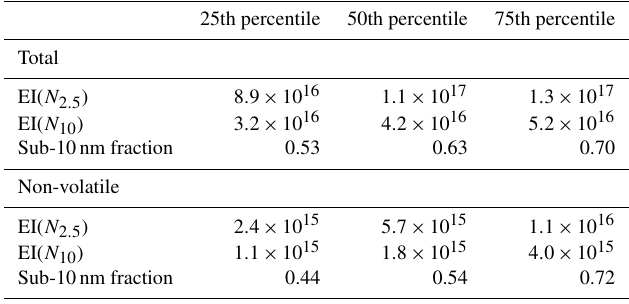
Table 2. Particle number emission indices (EIs) (particles per kilo- gram of fuel) and sub-10nm